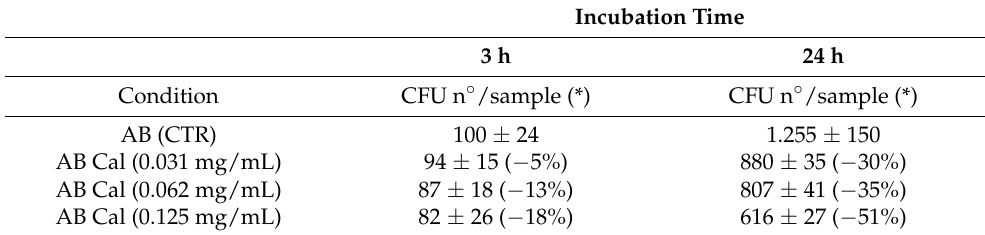
Table 4. Antifungal activity of Cal in aqueous buffer (AB).